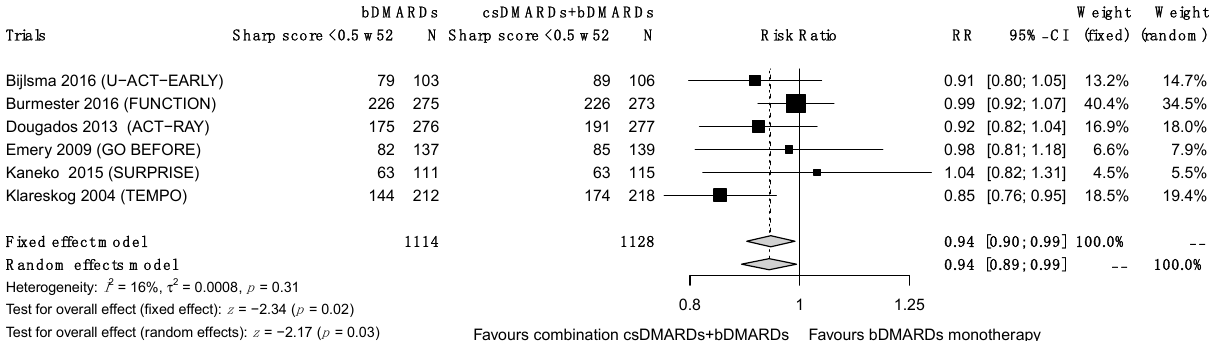
Figure 5. Sharp remission at 52 Figure 5.: Sharp remission at 52 weeks.